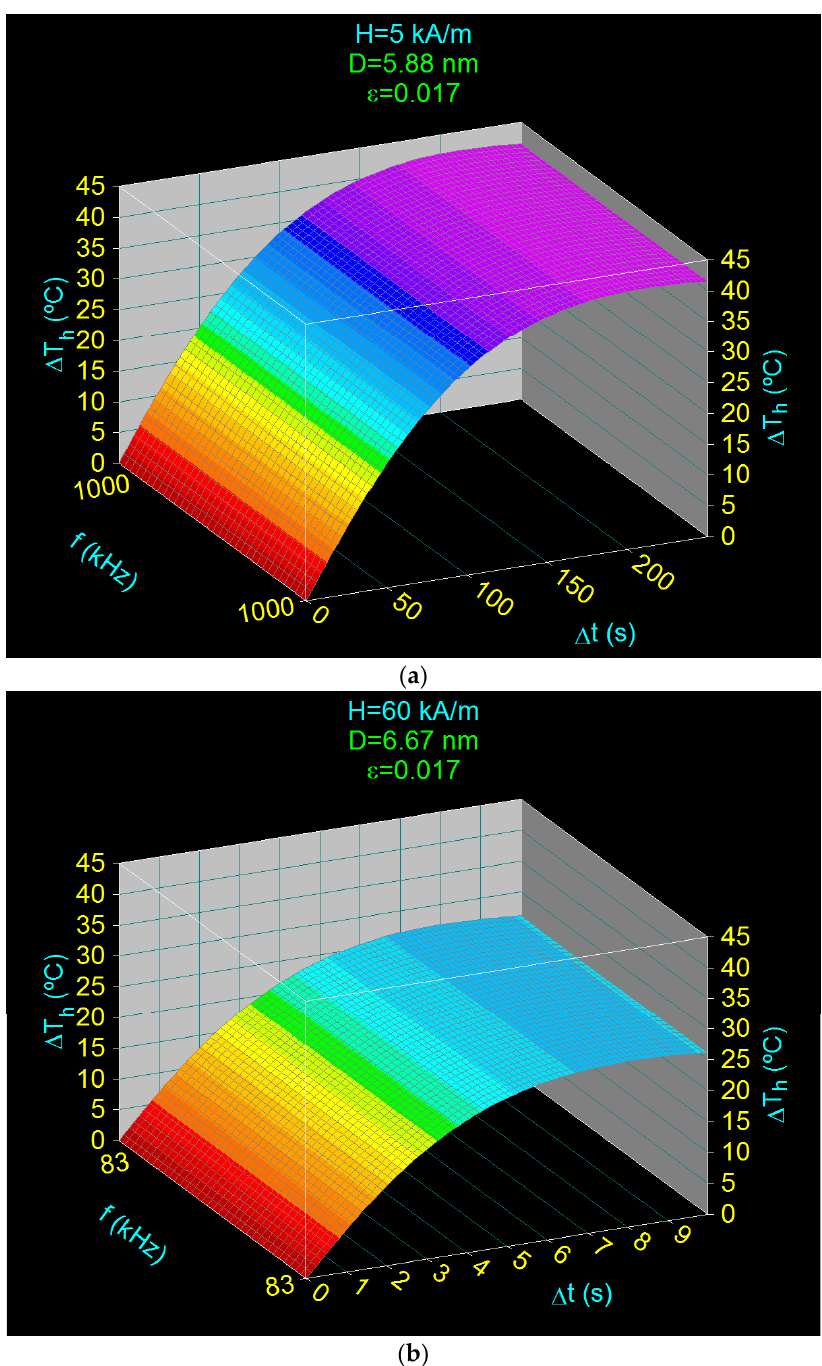
Figure 10. The time variation of heating temperature ( ∆ T h ) of CoFe 2 O 4 nanoparticles in optimal conditions given in Table 3 for volume fraction of 0.017 and two values of magnetic field: ( a ) 5 kA/m and ( b ) 60 kA/m.